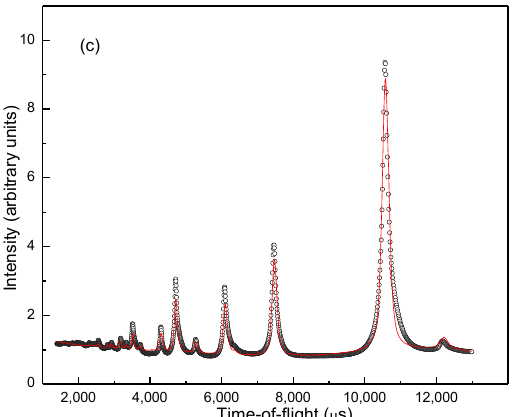
Figure 6. Reverse Monte Carlo (RMC) fits of Ti 0.63 V 0.27 Fe 0.10 D 1.73 to ( a ) G( r ), ( b ) F( Q ) and ( c ) Bragg peaks from neutron total scattering. Open circles are experimental functions and the solid lines are functions calculated from the RMC model.